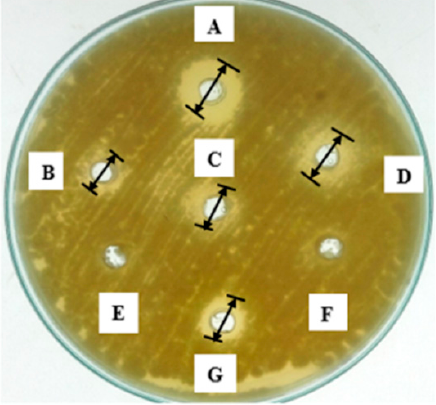
Figure 5. Antifungal potential of HPLC identified organic acids in L. coryniformis BCH-4 AMCs against A. flavus . A = Combination of acids, B = 2-hydroxybutanedioic acid, C = propanedioic acid, D = 2-hydroxypropane-1,2,3-tricarboxylic acid, E = 2-oxopropanoic acid F = butanedioic acid and G = 2- hydroxypropanoic acid. Well diameter was 8